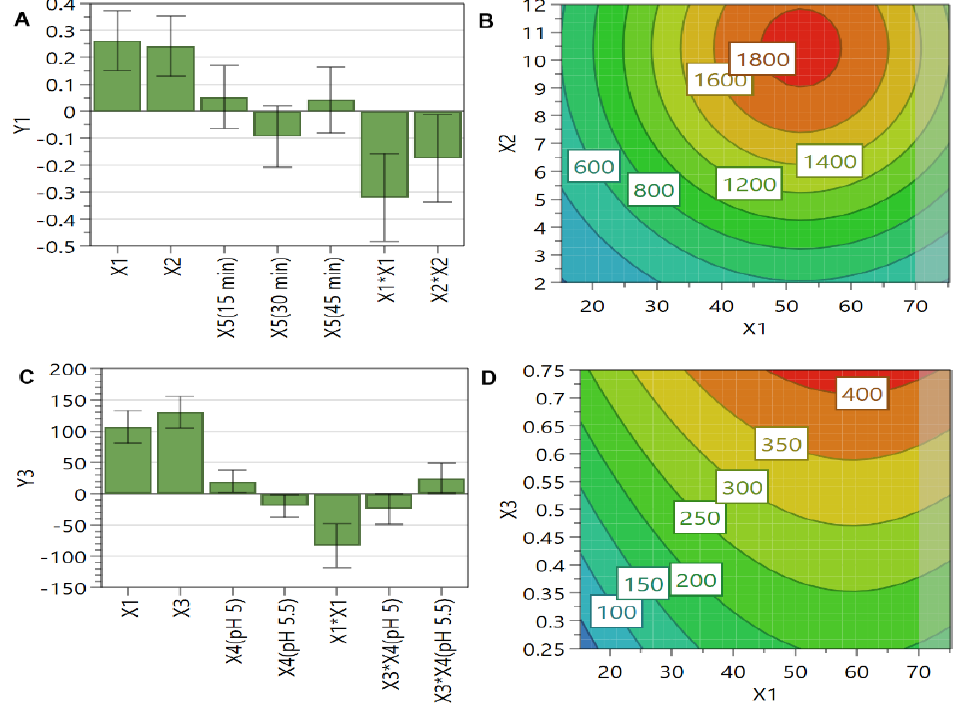
Figure 2. The coefficient plots for SIM ( A ) and DOX ( C ) entrapped concentration showing the significance of formulation factors in respect to these responses. The response contour plots for SIM ( B ) and DOX ( D ) entrapped concentration showing the variance of experimental results in respect to PL concentration (X1), SIM concentration (X2), and DOX concentration (X3). X1: PL concentration (mM); X2: SIM concentration (mM); X3: DOX concentration (mM); X4: the pH of the AS solution; X5: incubation time with DOX (min); Y1: SIM entrapped concentration ( µ g/mL); Y3: DOX entrapped concentration (µg/mL).